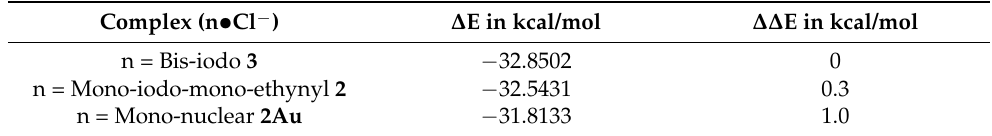
Table 4. Theoretically calculated binding energies for the chloride complexes of the series of “two wall” calix[4]pyrrole receptors.